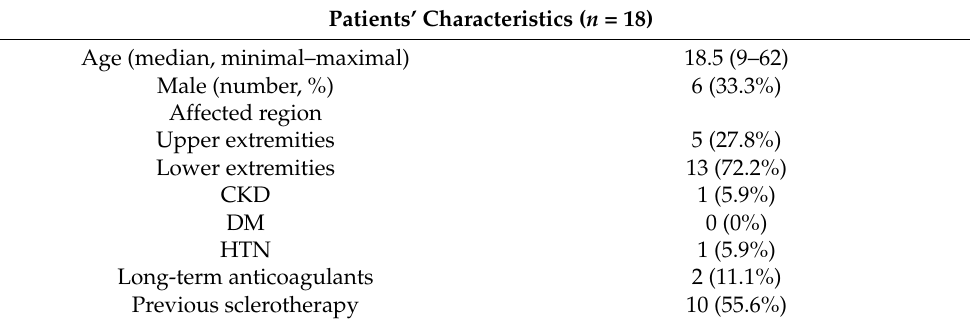
Table 1. Patients’ characteristics.